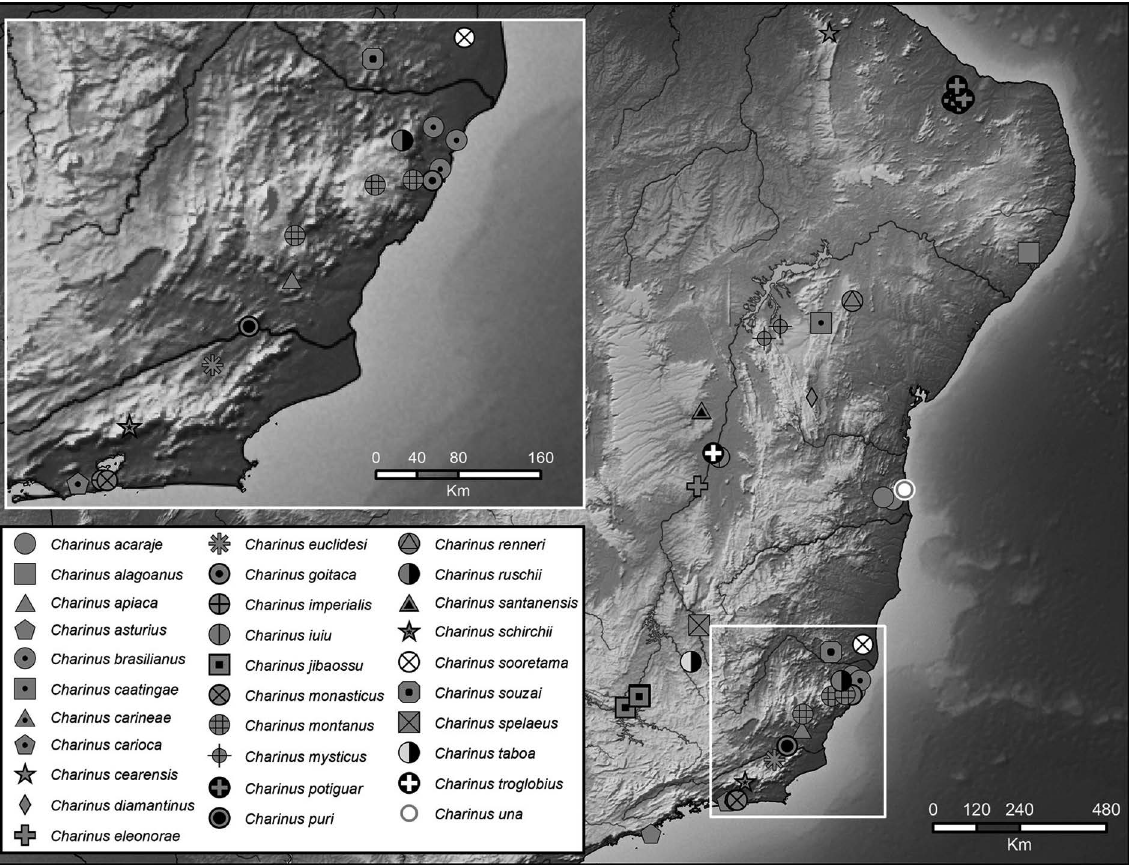
Fig. 43. Map plotting known distributions of species of Charinus Simon, 1892 in eastern South America, with inset for